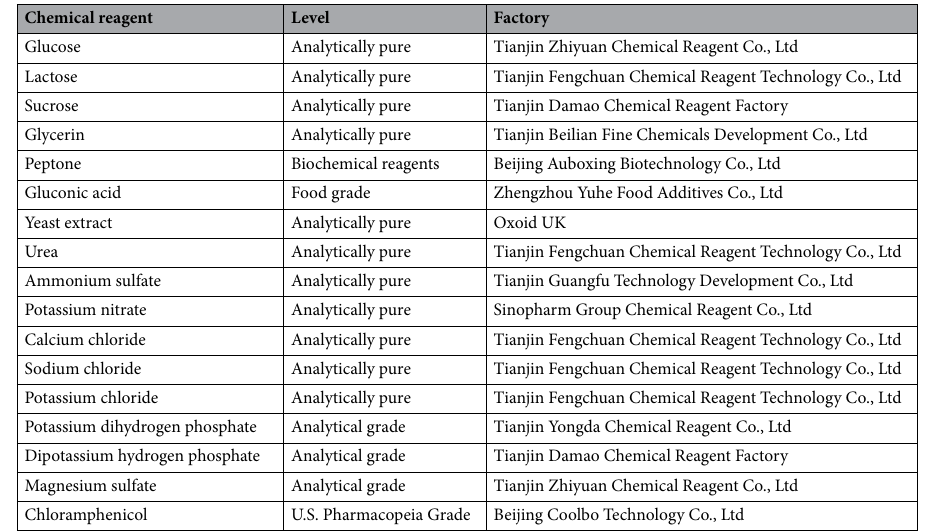
Table 1. Experimental reagents.